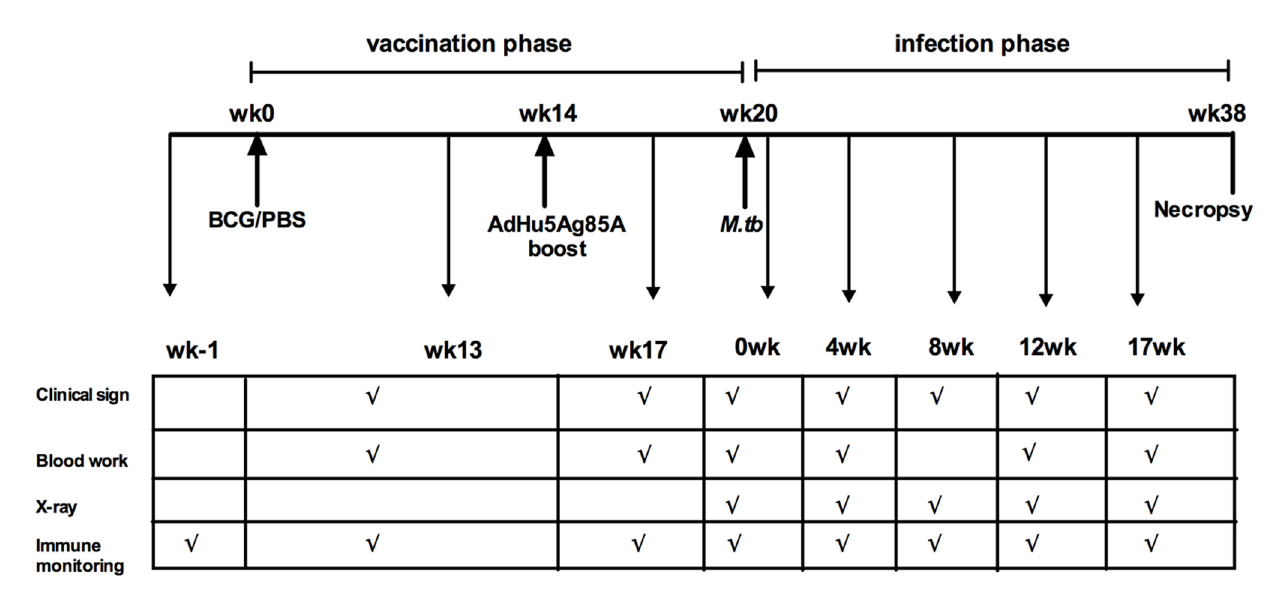
Fig 1. Experimental schema and plan. Depicting the timelines of vaccination (BCG priming at wk0 and AdHu5Ag85A boosting at wk14), M . tb infectious challenge (wk20) and fixed endpoint/autopsy (wk38). Scheduled times for clinical signs, blood work for acute phase protein measurement, chest X-ray and immune monitoring are indicated. Timelines during infection phase are referred relative to the 18 weeks post-challenge timepoint (indicated within parentheses).